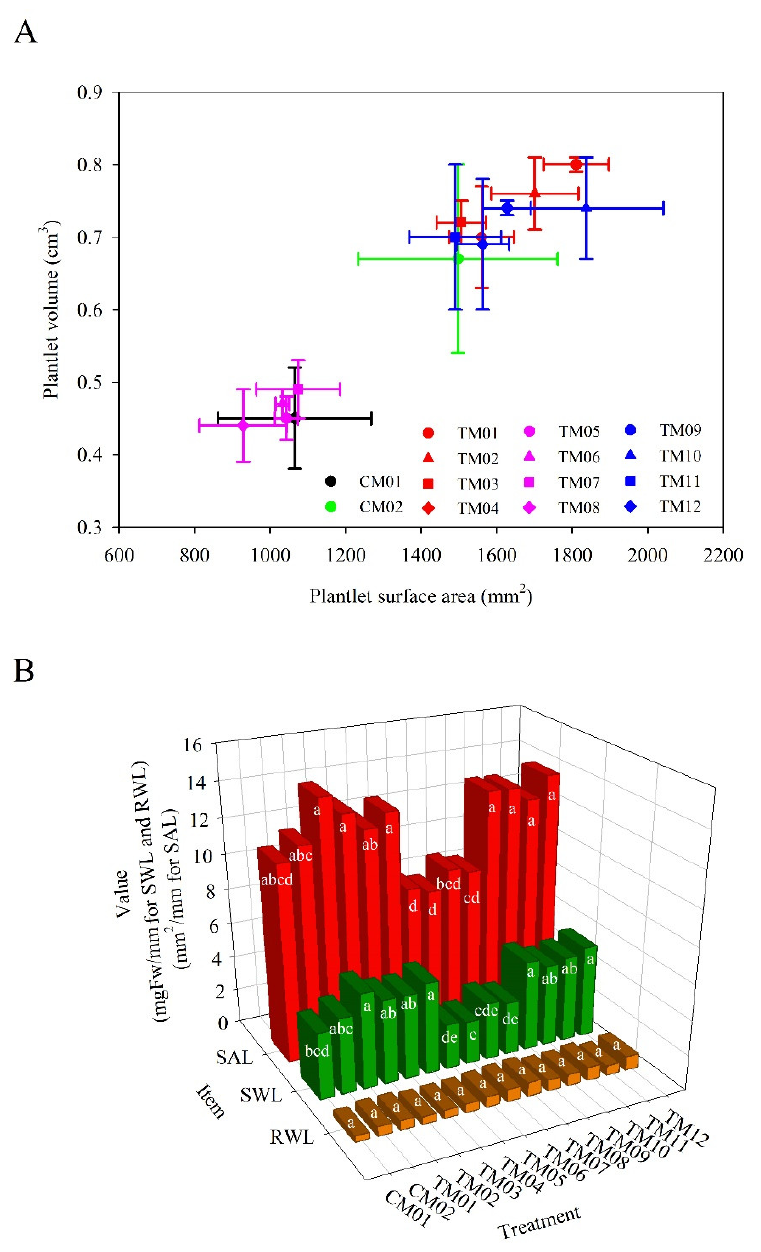
Figure 6. Relationship between plantlet surface area and plantlet volume ( A ) and shoot surface area per unit length (SAL; Surface area shoots /Length shoots ), shoot weight per unit length (SWL; FW shoots /Length shoots ), and root weight per unit length (RWL; FW roots /Length main root ) ( B ) of Hylocereus polyrhizus ‘Da Hong’ cultured on Murashige and Skoog (MS) medium supplemented with activated charcoal (AC) combined with α -naphthaleneacetic acid (NAA) and 6-benzylaminopurine (BAP). Treatments: CM01, control; CM02, 200 mg/L AC; TM01, 200 mg/L AC and 0.05 mg/L NAA; TM02, 200 mg/L AC, 0.05 mg/L NAA, and 1.00 mg/L BAP; TM03, 200 mg/L AC, 0.05 mg/L NAA, and 2.00 mg/L BAP; TM04, 200 mg/L AC, 0.05 mg/L NAA, and 4.00 mg/L BAP; TM05, 200 mg/L AC and 0.10 mg/L NAA; TM06, 200 mg/L AC, 0.10 mg/L NAA, 1.00 mg/L BAP; TM07, 200 mg/L AC, 0.10 mg/L NAA, and 2.00 mg/L BAP; TM08, 200 mg/L AC, 0.10 mg/L NAA, and 4.00 mg/L BAP; TM09, 200 mg/L AC and 0.20 mg/L NAA; TM10, 200 mg/L AC, 0.20 mg/L NAA, and 1.00 mg/L BAP; TM11, 200 mg/L AC, 0.20 mg/L NAA, and 2.00 mg/L BAP; TM12, 200 mg/L AC, 0.20 mg/L NAA, and 4.00 mg/L BAP. Mean ± SE ( n = 3, 5 segments per replicate). Means associated with different letters near the columns are significantly different at p = 0.05 using Fisher’s protected LSD test.